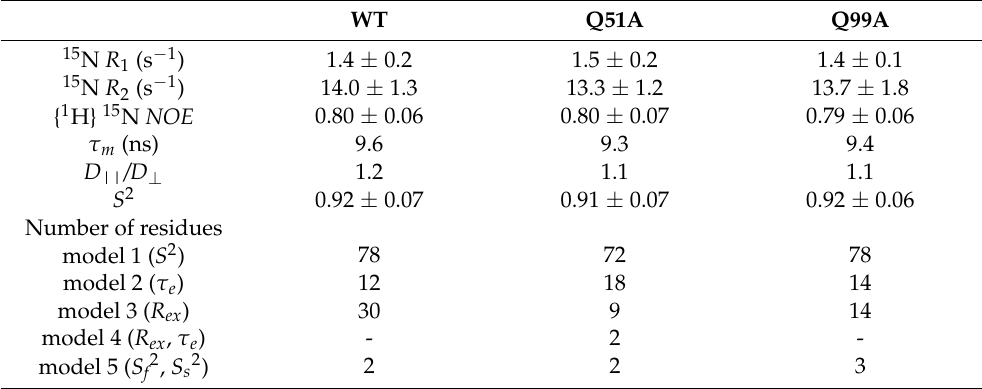
Table 1. Summary of 15 N NMR spin-relaxation rates, generalized order parameters, and the number of residues with τ e and R ex contributions according to Model Free analysis of 15 N backbobe relaxation measurements for the investigated human I-BABP variants (283 K). Physical quantities are italicized.